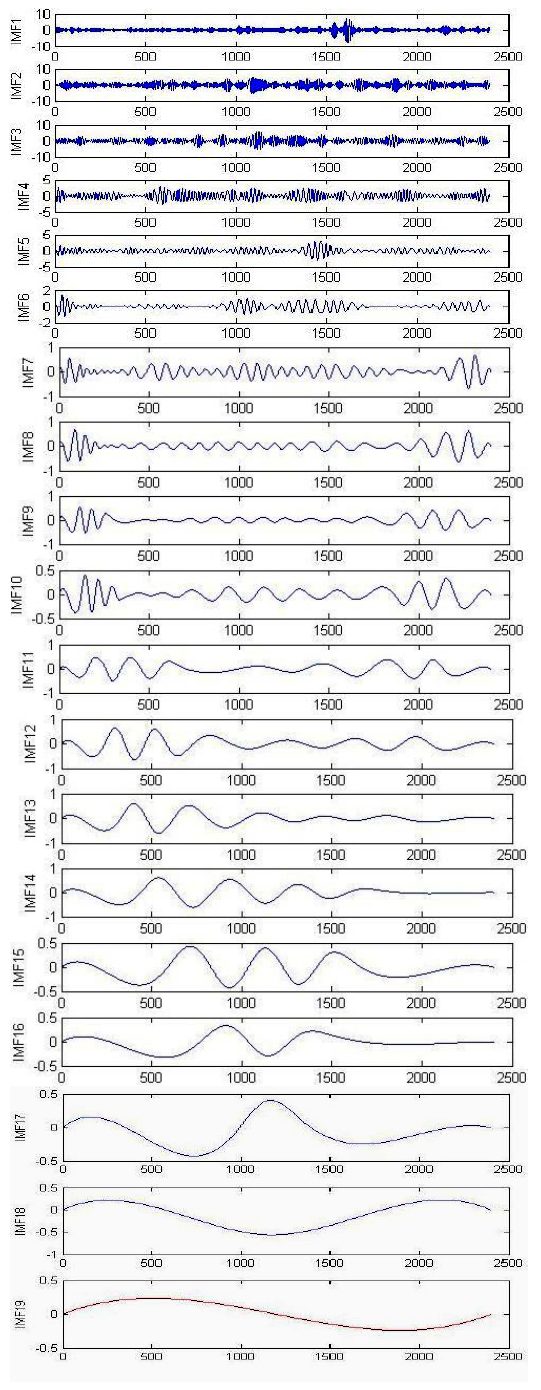
Figure 5. The empirical mode decomposition of the electromyography signal from right vastus medialis during maximum walking